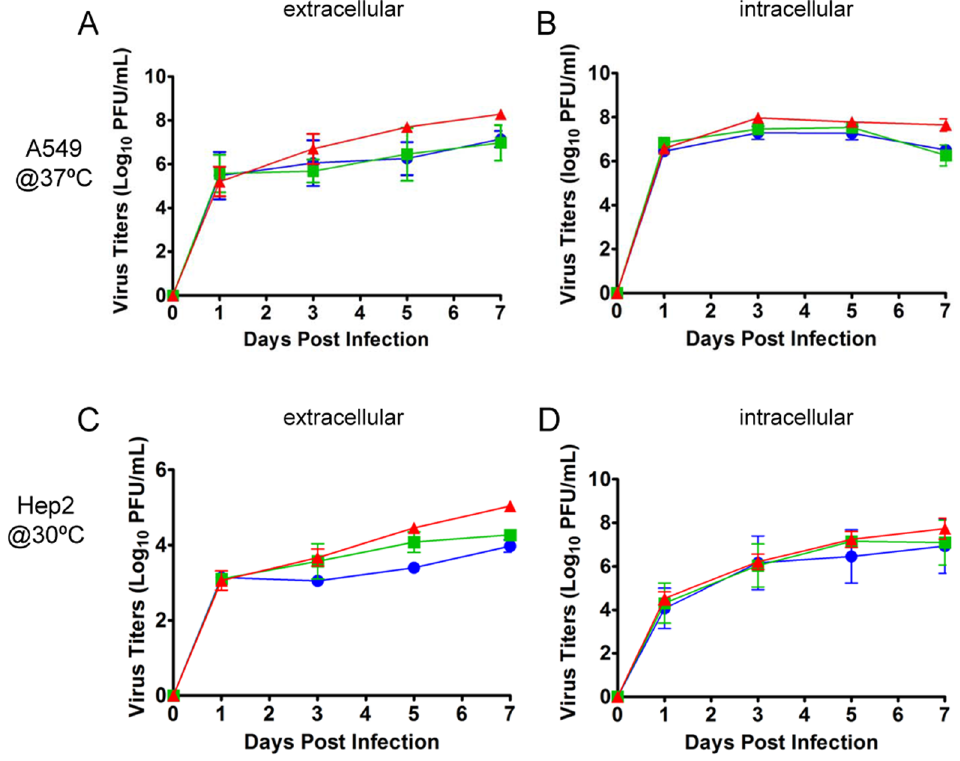
Figure 2. Viral growth kinetics of HAdV-B55, HAdV-B14 and HAdV-B11 in A549 and HEp-2 cells. A549 (A & B) and HEp-2 (C & D) cells were infected with HAdV-B11 (blue), HAdV-B14 (green) or HAdV-B55 (red) at an MOI of 0.1, and the supernatants and cells were separately harvested at 1, 3, 5 and 7 d post-infection. The supernatants samples were titrated by a plaque assay on A549 cells. Viral titers in the cell samples were determined by qPCR. The data are shown as the mean 6 standard deviation of three independent experiments. A & C, the extracellular viral loads in the supernatants. B & D, the intracellular viral loads in the cells.